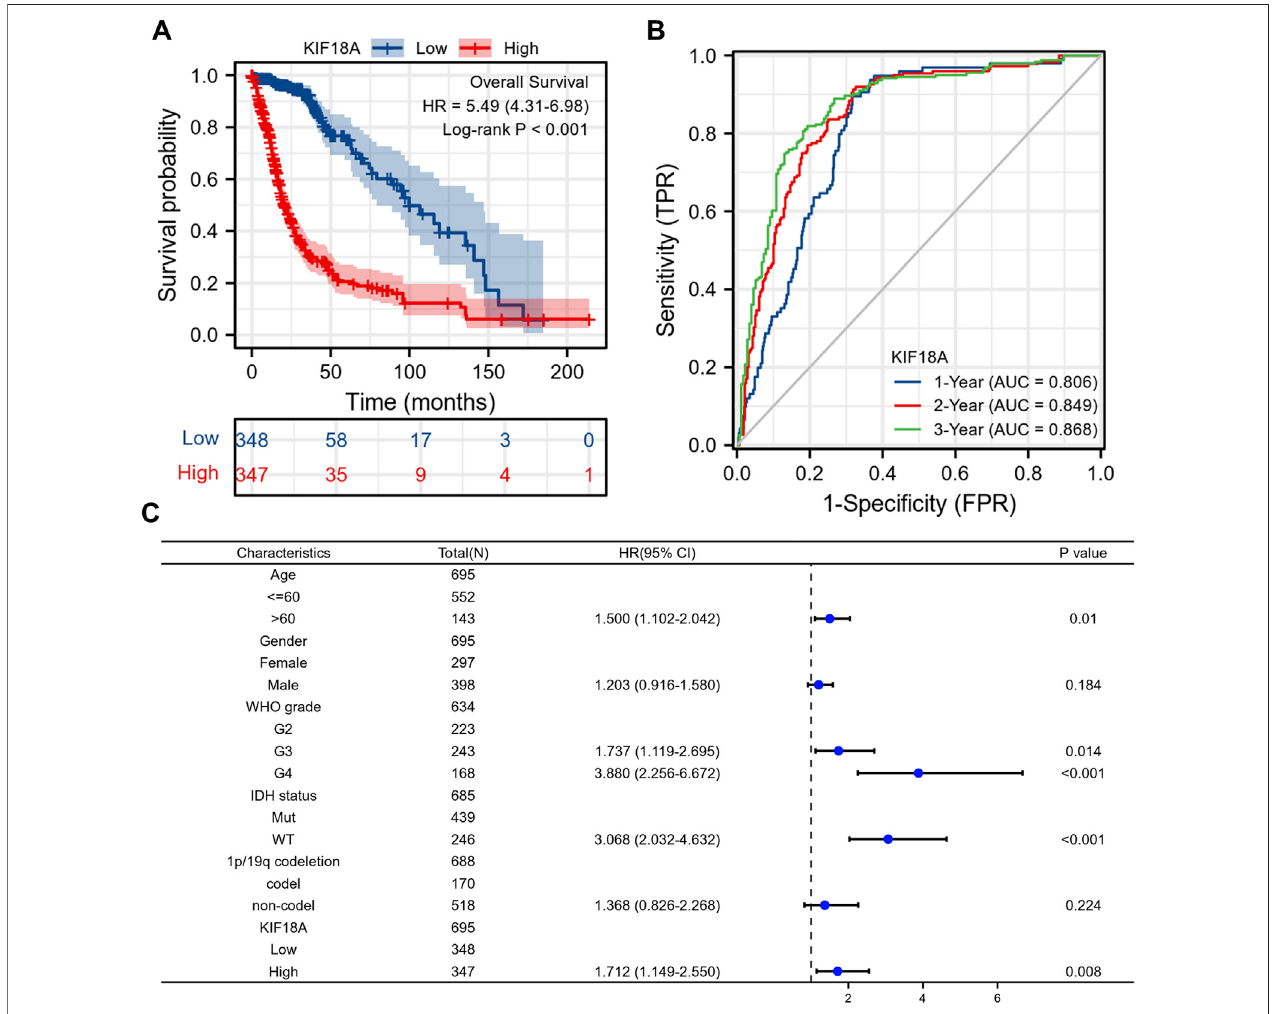
FIGURE 5 | The correlations between KIF18A mRNA expression level and the overall survival rate of patients. (A) Kaplan – Meier plots of KIF18A; (B) time- dependent ROC curves of KIF18A. (C) Multivariate Cox analysis of KIF18A expression and clinicopathological characteristics.